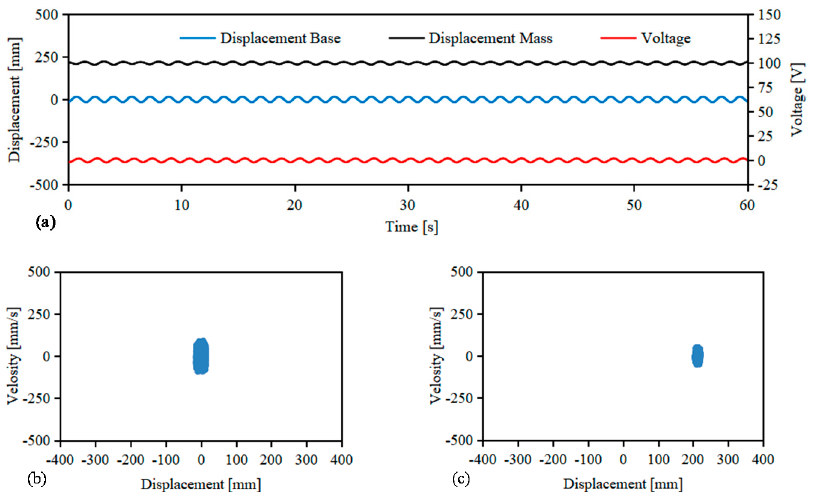
Figure 11. Measurement results of response vibration displacement and vibration power generation when vibrating with a period signal 0.6 Hz. ( a ) Results of response vibration displacement. ( b ) Diagram of displacement velocity of vibration of the support. ( c ) Diagram of displacement velocity of vibration of the mass block.